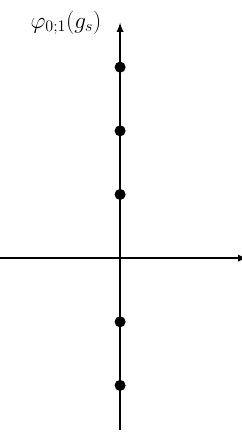
Figure 7: The singularities in the Borel plane for the series ϕ